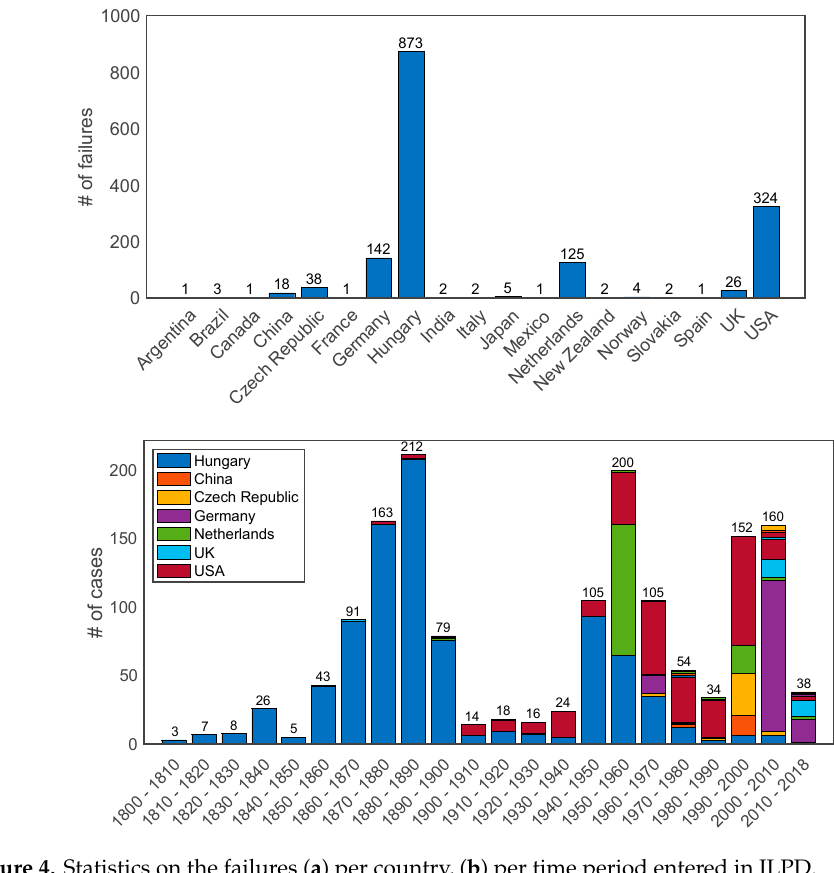
Water 2019 , 11 , x FOR PEER REVIEW Figure 4. Statistics on the failures ( a ) per country, ( b ) per time period entered in ILPD.